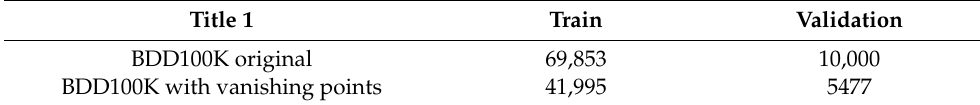
Table 2. Number of BDD1000K Data.